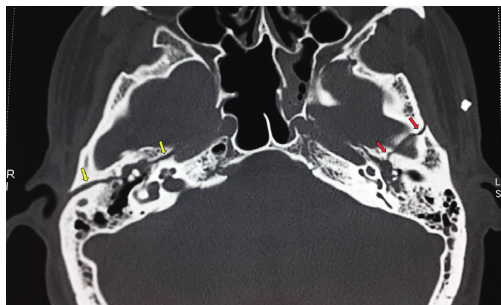
Figure 2: Transverse section of cranial CT (plane of incudo- malleolar joint) showing right longitudinal otic-sparing temporal bone fracture (yellow arrows) and left transverse temporal bone fracture (red